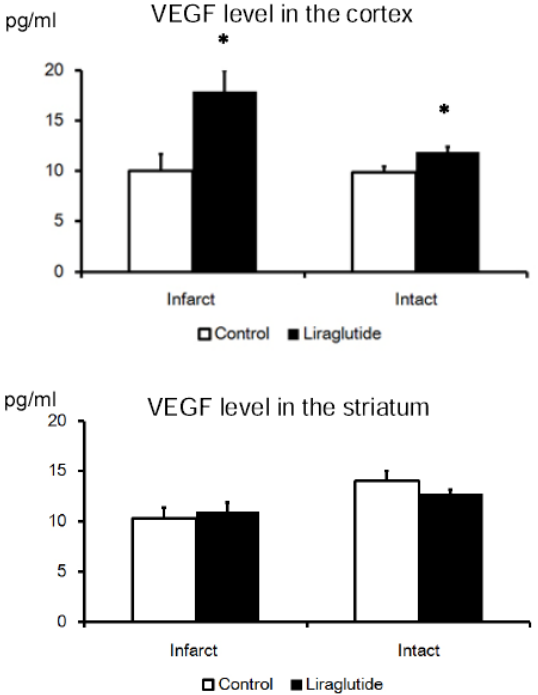
Figure 5. VEGF upregulation in the cortex of rats receiving liraglutide. Upper graph : The graph demonstrates significant increase of VEGF level in the cortex of liraglutide-treated rats; Lower graph : The level of VEGF in the striatum was not increased by administration of liraglutide. Infarct/Intact means tissues in the infarct/intact side, respectively. * p < 0.05 vs. control